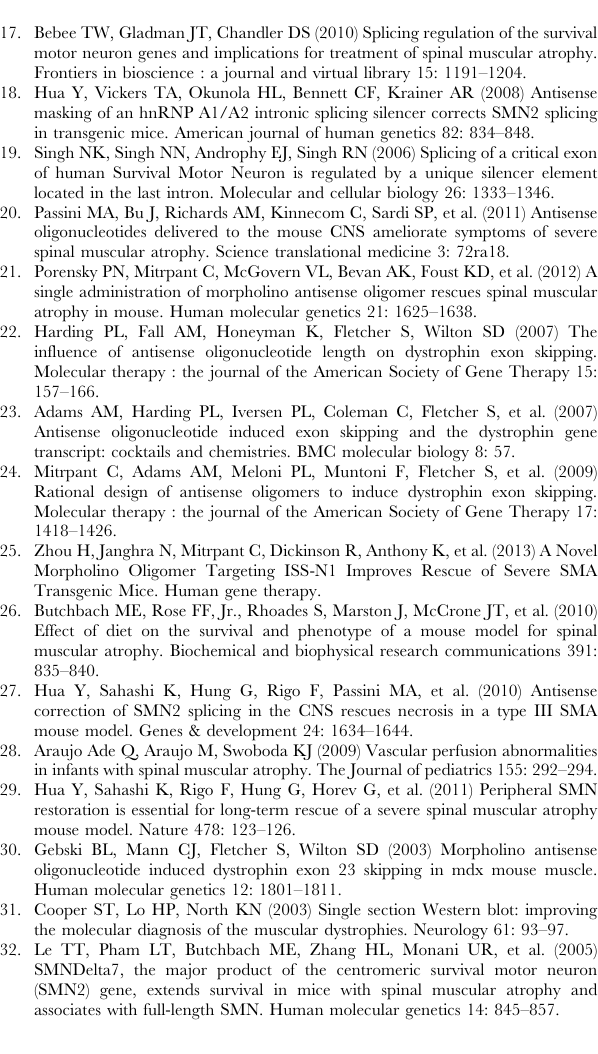
Figure S1 Schematic diagram representing PMO bind- ing coordinates on human SMN2 intron